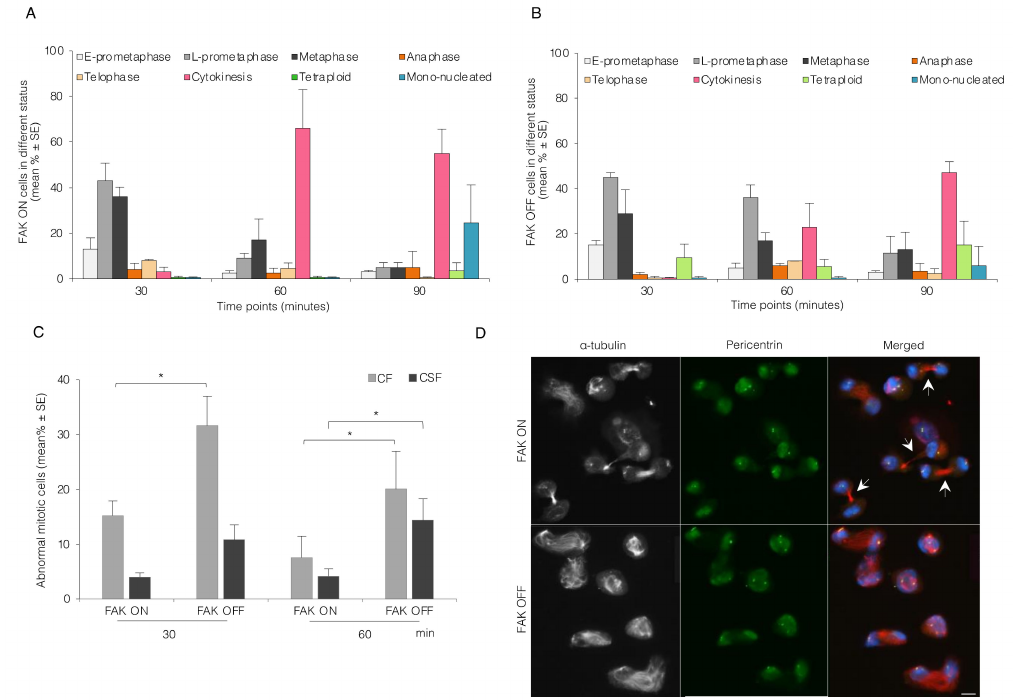
Figure 5. Inhibition of FAK expression in Tet-FAK MEF cells impairs centrosome separation and bipolar spindle formation. ( A , B ) Mean (%) ± SE of the number of Tet-FAK ON ( A ) and Tet-FAK OFF cells ( B ) in different mitotic stages as described in Figure 1B. ( C ) Mean (%) ± SE of the number of Tet-FAK ON and OFF cells containing abnormal centrosomes (CF and CSF) present at different mitotic stages. ( D ) Representative immunofluorescence pictures illustrating FAK ON and FAK OFF cells 60 min after release from mitotic block. The arrows point to the microtubule bundle of cytokinetic cells (FAK ON). Pericentrin (green), α -tubulin (red/white), and DAPI (blue). Scale bar, 10 µ m. p -values less than 0.05, were shown by one